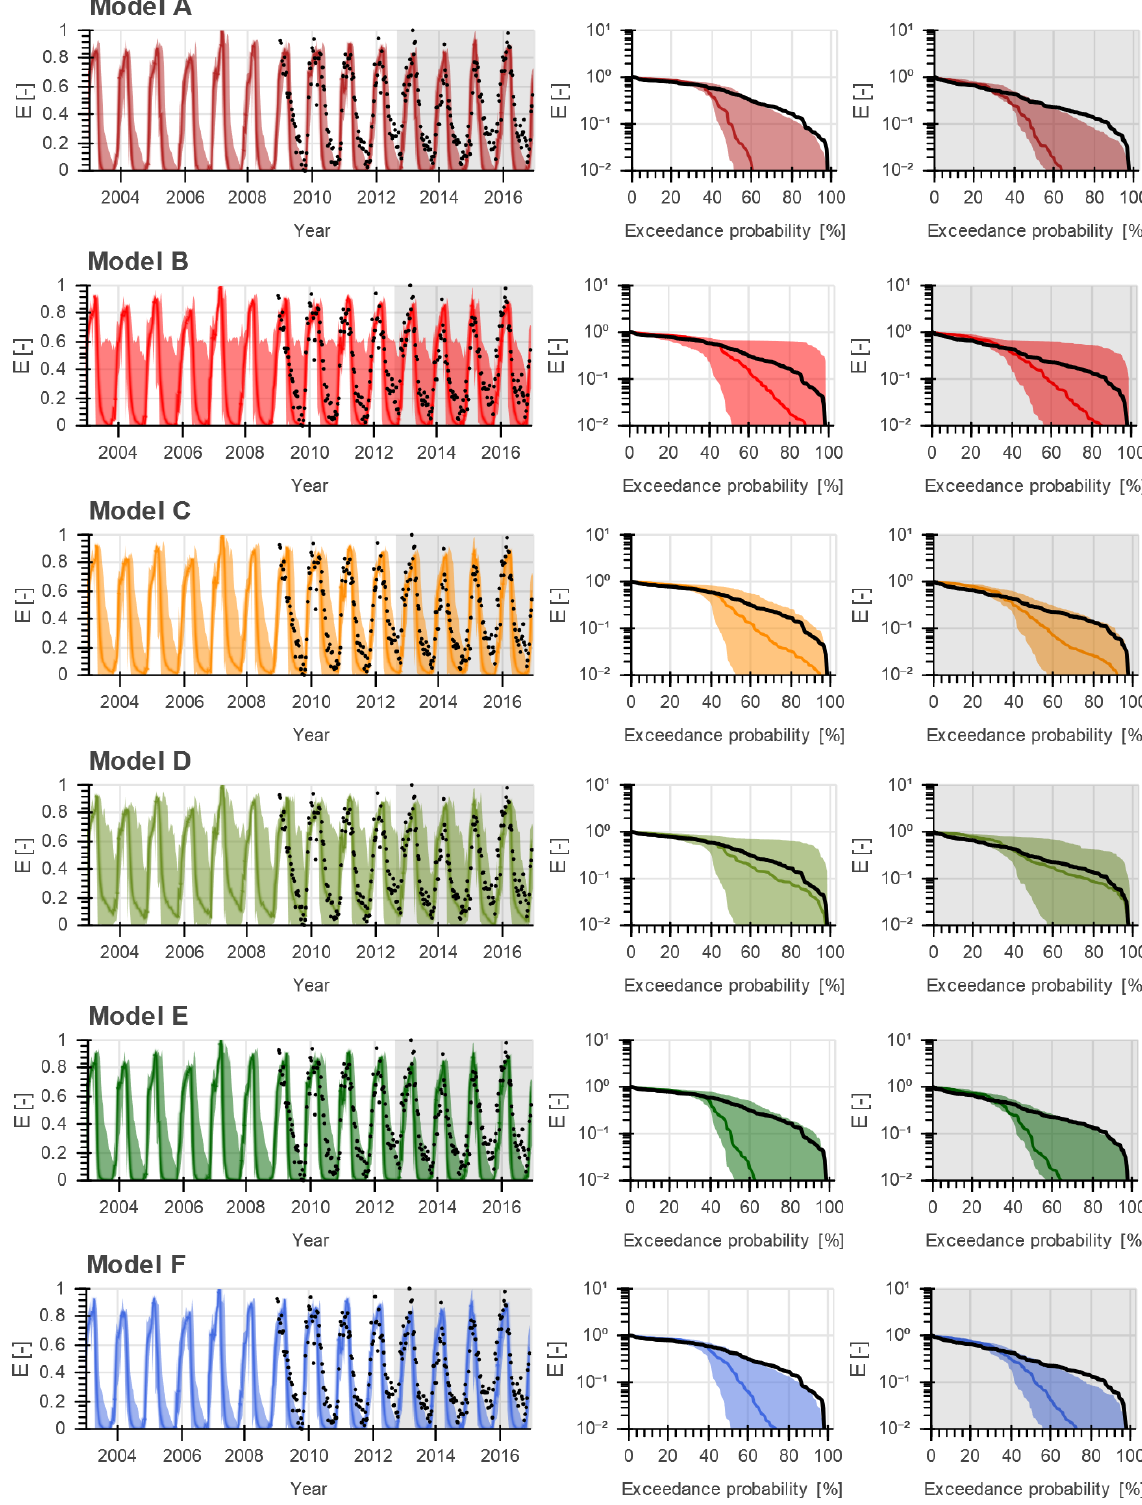
Figure 10. Range of model solutions for Models A to F. The left panels show the time series and the right panels the duration curve of the recorded (black) and modelled normalized evaporation for wetland-dominated areas: the line indicates the solution with the highest calibration objective function with respect to multiple variables ( D E , ES Q cal ) and the shaded area the envelope of the solutions retained as feasible. The data in the grey shaded area were used for